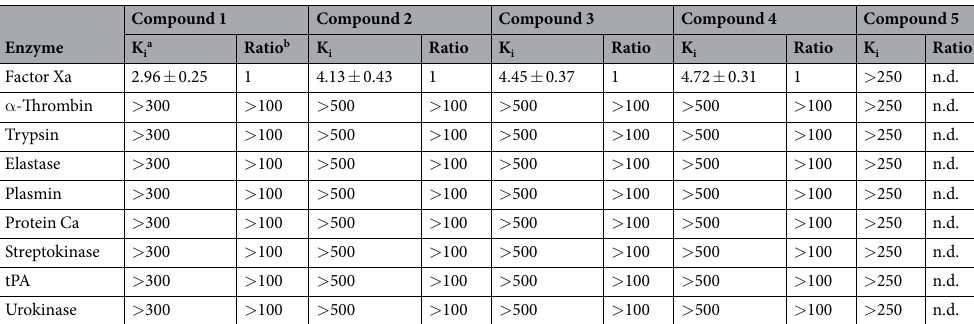
Table 4. Enzyme kinetics and selectivity of isolated compounds against different human enzymes. a K i